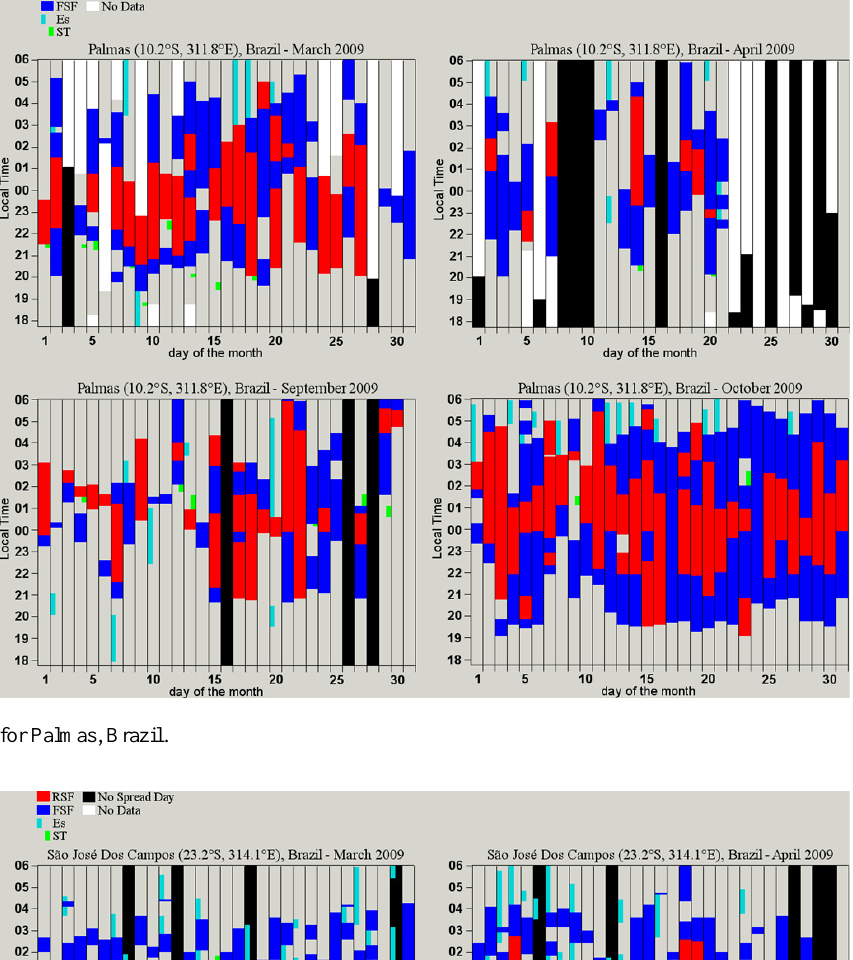
Fig. 7. Same as Fig. 5 for Palmas, Brazil.